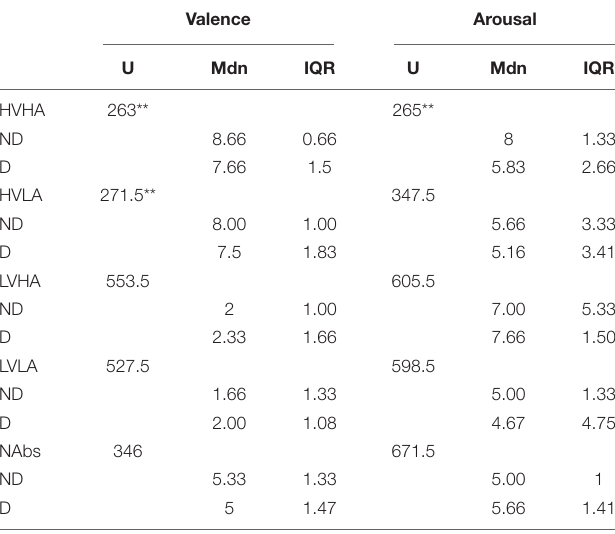
TABLE 3 | Affective rating on valence and arousal